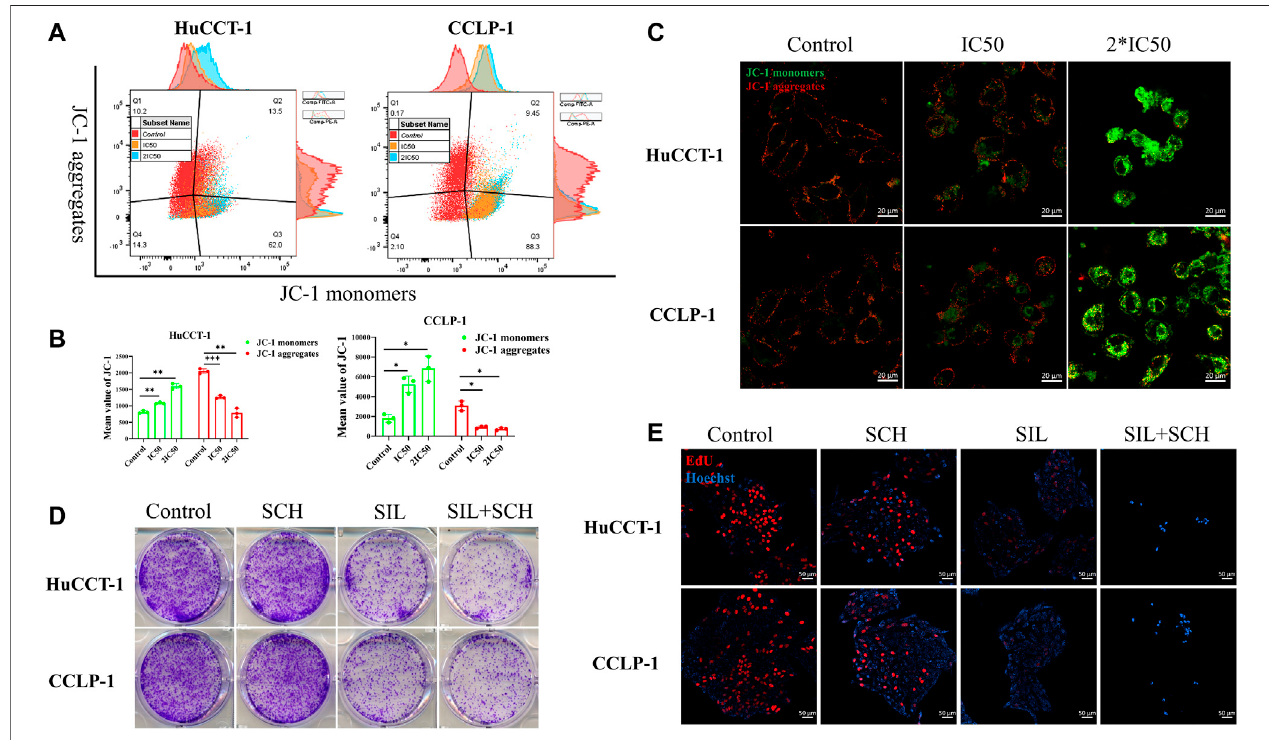
FIGURE5| SilibininactsontheERKprotein,causingadecreaseinmitochondrialmembranepotential. (A,B) .FCMresultsofthemitochondrialmembranepotential changes in cholangiocarcinoma cells. Cells were treated with IC50 and 2*IC50 concentrations of silibinin for 48 h. Data is shown as mean ± SD, * p < 0.05, ** p < 0.01, *** p < 0.001, signi fi cantly different compared to the control group. (C) . Mitochondrial membrane potentialchanges were observed by confocal microscopy after silibinin treatment. Red fl uorescence indicates aggregates and green fl uorescence indicates monomers. (D) . Colony formation assay results of HuCCT-1 and CCLP-1 cell lines treated with silibinin and SCH772984. (E) . EdU proliferation assay results of HuCCT-1 and CCLP-1 cell lines treated with silibinin and SCH772984.